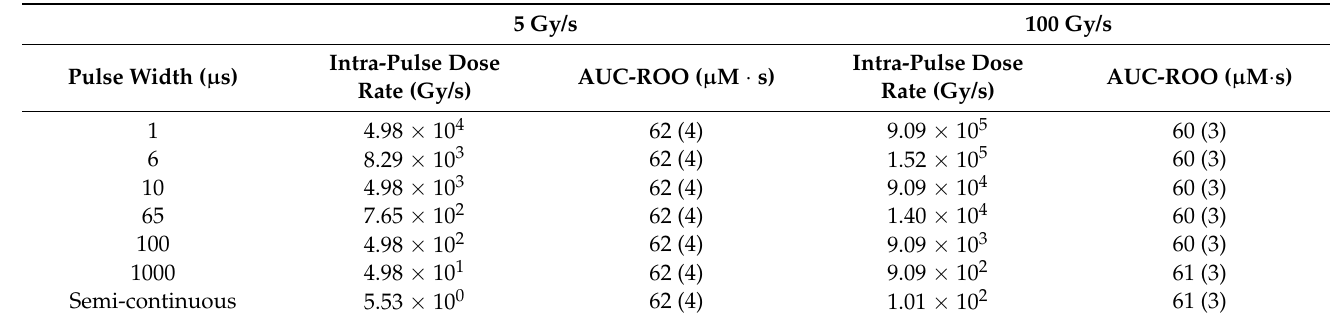
Table 4. Integral production of the ROO • radical for mean dose rates of 5 and 100 Gy/s and corre- sponding irradiation parameters used in the simulations of different pulse widths, keeping the pulse repetition frequency at 100 Hz. Reported data uncertainties correspond to one standard